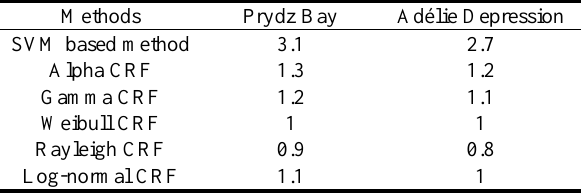
Table V Computation time of different algorithms (in